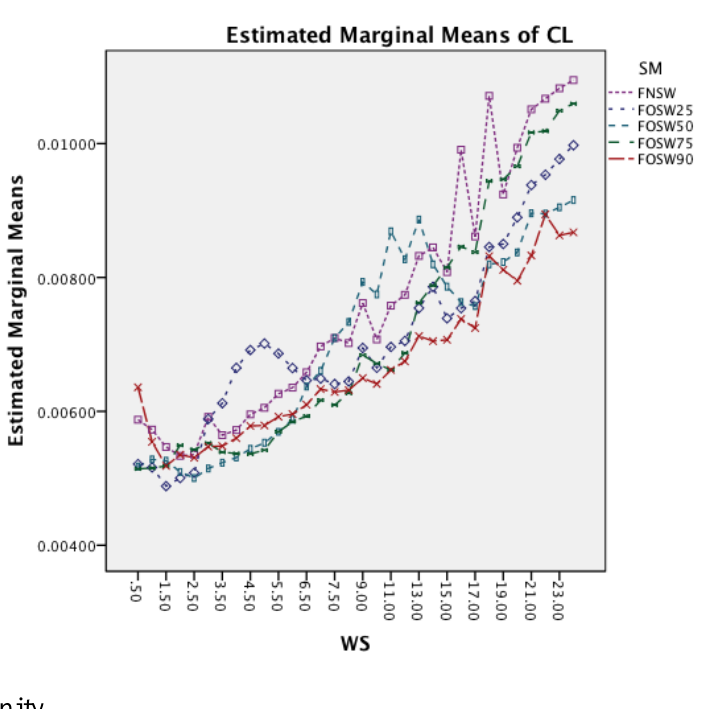
Figure 16. Two-way interaction effect for WS and SM.